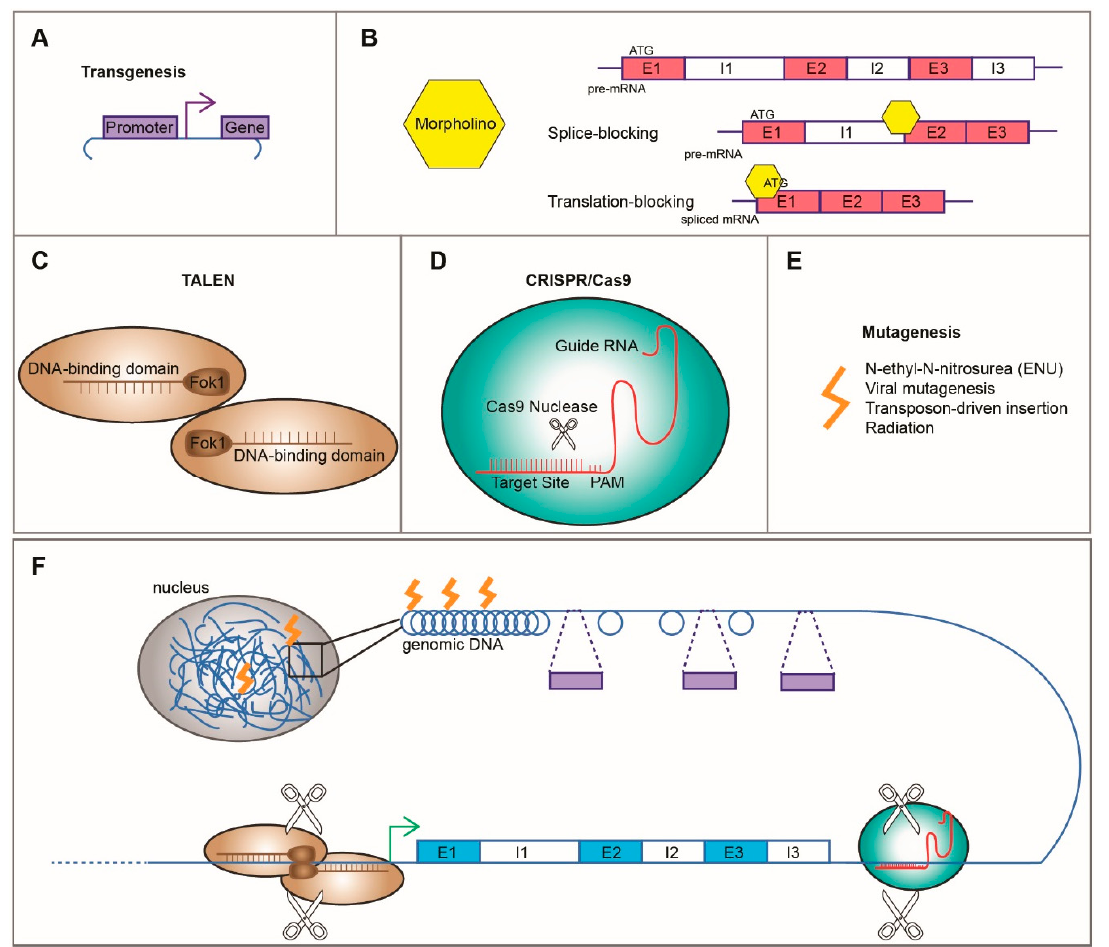
Figure 3. Common tools used in zebrafish include ( A ) transgenic insertion of foreign DNA; ( B ) suppression of gene expression by splice-blocking or translation-blocking morpholinos; ( C ) targeted genome editing by TALE-associated nucleases (TALEN); ( D ) targeted genome editing by CRISPR-associated Cas9 nucleases; and ( E ) chemical mutagenesis; ( F ) Schematic illustrating how these tools modify genomic DNA.